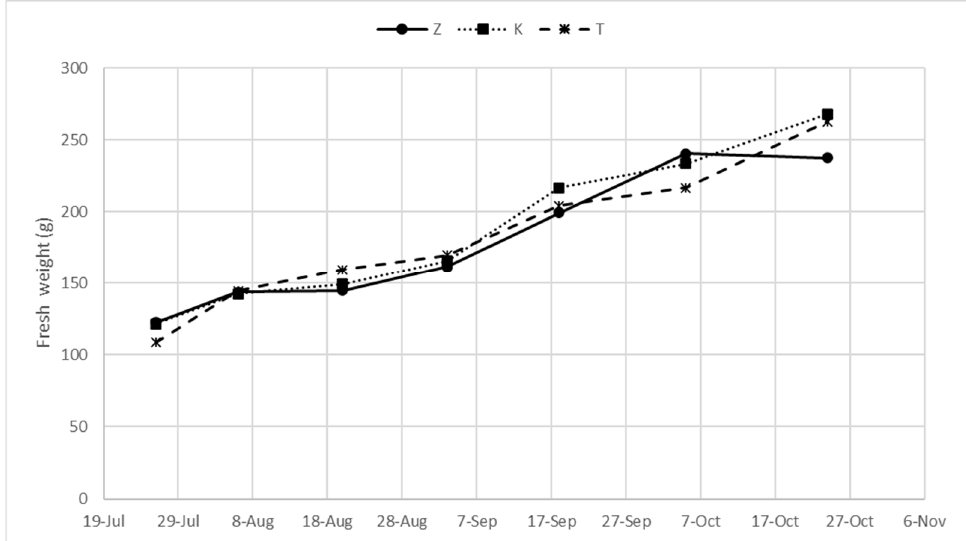
Figure 1. Olive development during the experimental trial expressed as g of fresh weight (T = untreated control, Z = zeolitite, K = kaolin). (T = untreated control, Z = zeolitite, K =